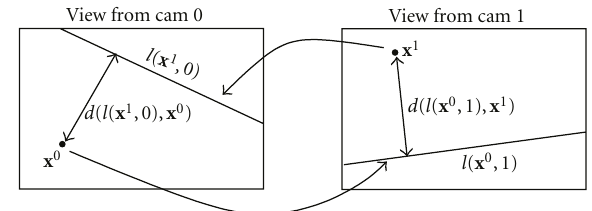
Figure 3: Symmetric epipolar distance between two points d SE ( x 0 , x 1